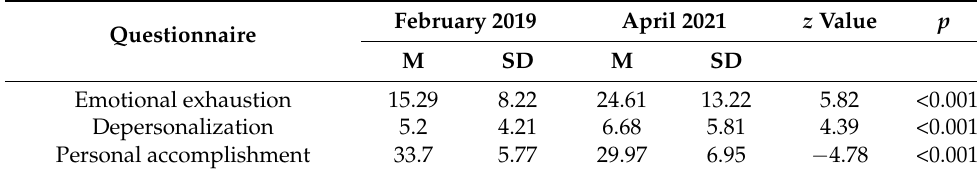
Table 4. Statistics on burnout